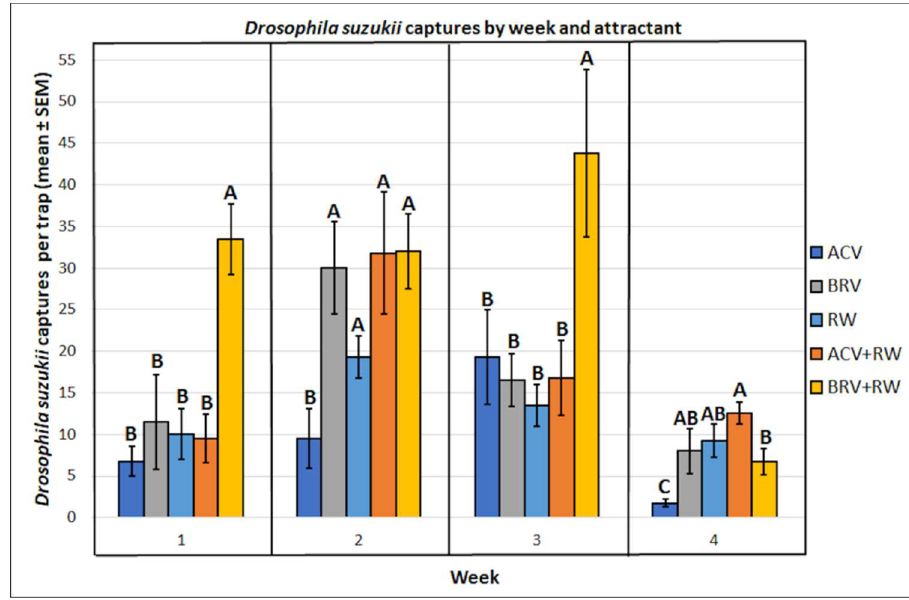
Figure 5. Mean (± SEM) Drosophila suzukii captures per trap by week and attractant. Different letters represent statistically significant differences ( p < 0.05, Tukey’s HSD test) between attractant solutions.